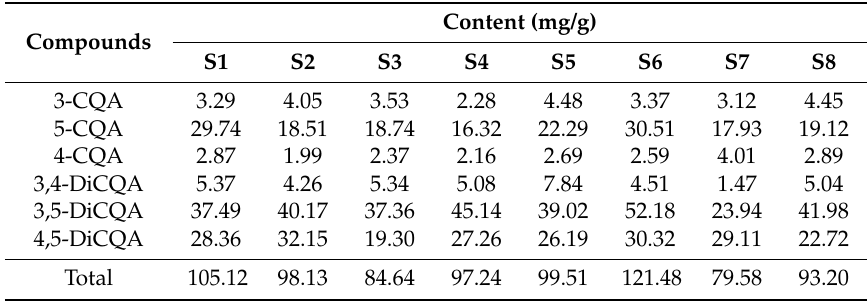
Table 3. The contents of 6 investigated CQAs in Kuding tea from different